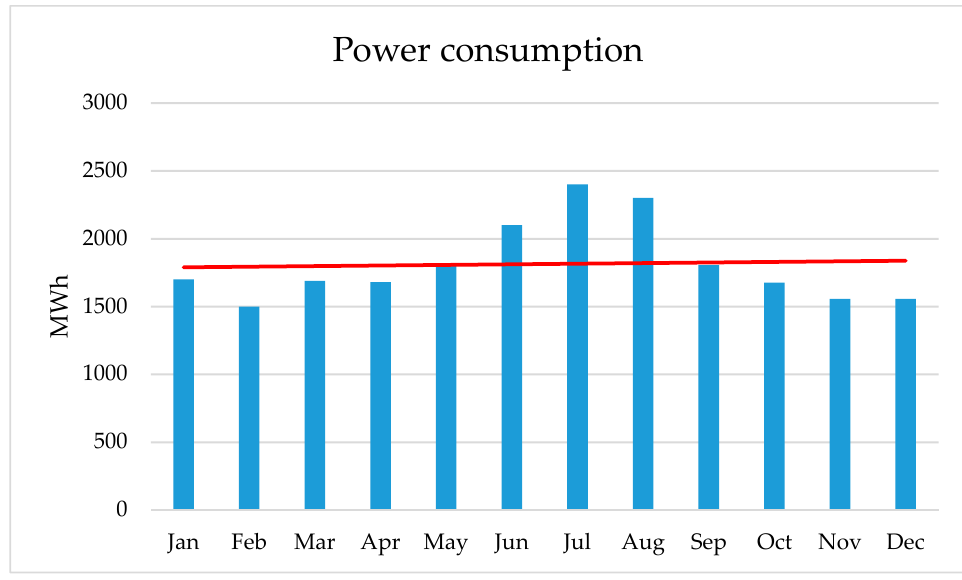
Figure 3. Power consumption of the building in one year, without changes in the cooling system.